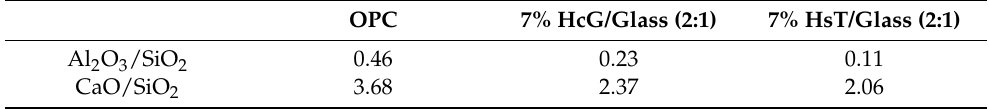
Table 8. 90-day OPC and C-S-H gel Table 8. 90 ‐ day OPC and C ‐ S ‐ H gel ratios.